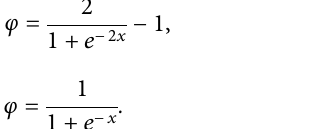
Figure 4: Topology of the neural